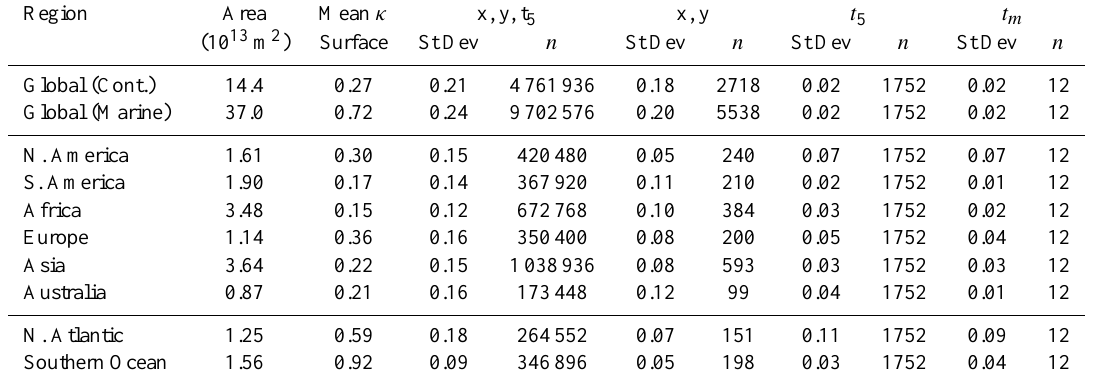
Table 3. Standard deviation (St Dev) of κ values calculated considering variation in i) all dimensions (x, y, t 5 = area and time ( t 5 = 5 hourly time intervals)), ii) area only (x, y), iii) time only (t 5 = 5 hourly time intervals) and iv) time only ( t m = monthly mean values used). For each standard deviation value the adjacent column (to the right) shows the number of data points used in the calculation ( n ). Region Area Mean κ x, y, t 5